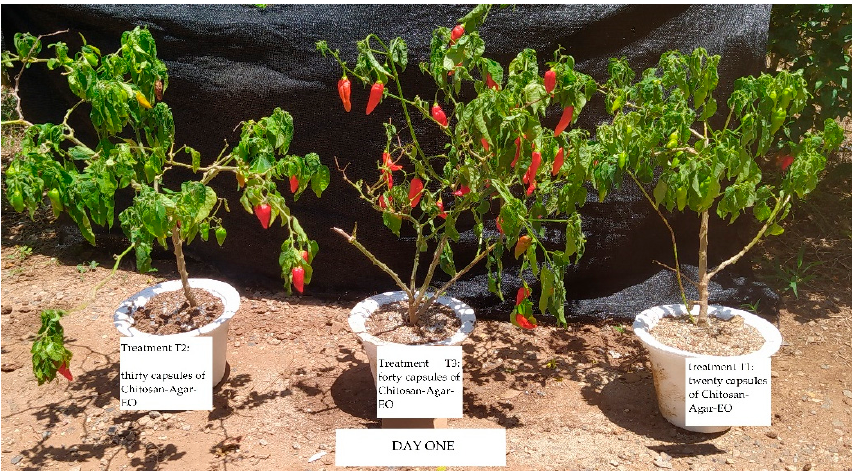
Figure 7. Day 1 of the test to evaluate the antifungal activity of EO capsules in greenhouse conditions: Topito chili plants infected with 1 × 10 6 conidia mL − 1 with treatments of 20, 30, and 40 capsules of (Chitosan-Agar-EO) from Cymbopogon citratus.